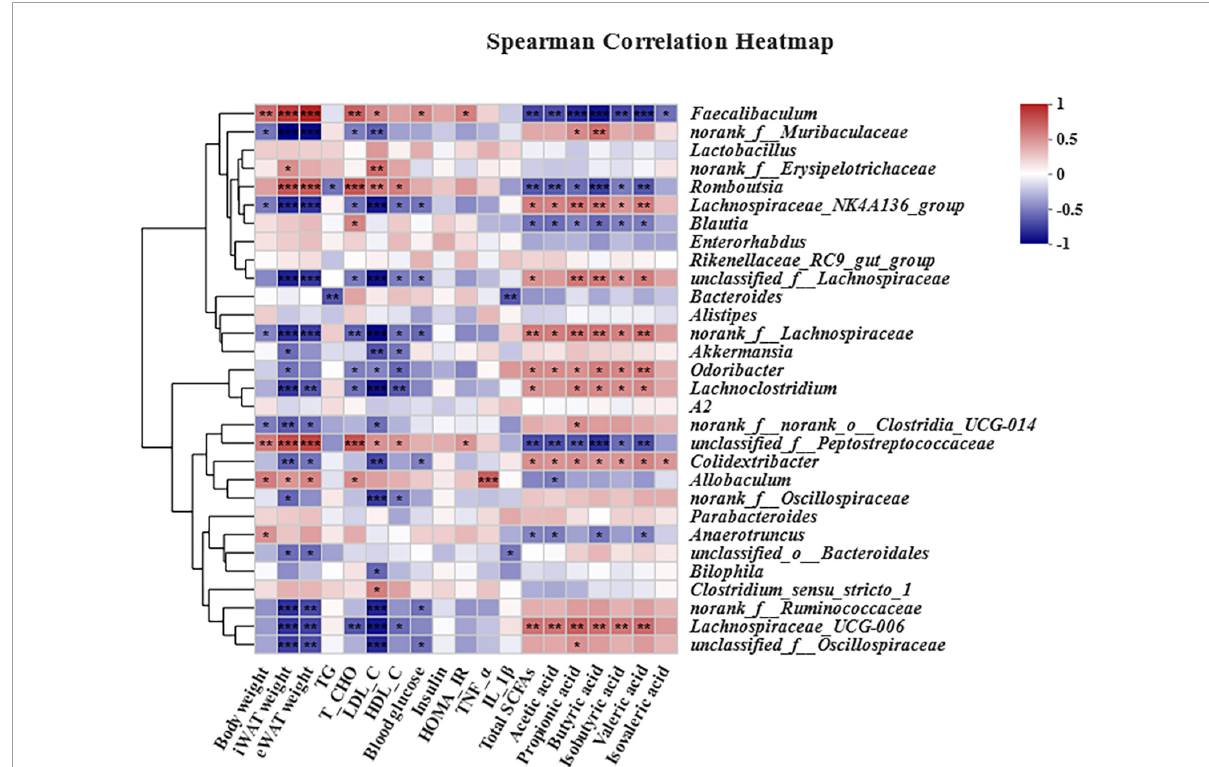
FIGURE9 Heatmap of Spearman’s correlations between gut bacteria relative abundances and obesity-related indices. The top 30 most abundant genera in each sample were used for the hierarchical clustering and heatmap analyses based on Spearman’s correlation coefficients. The red and blue blocks represent positive and negative correlations, respectively. Significant correlations are indicated by * p < 0.05, ** p < 0.01, and *** p < 0.001 ( n =